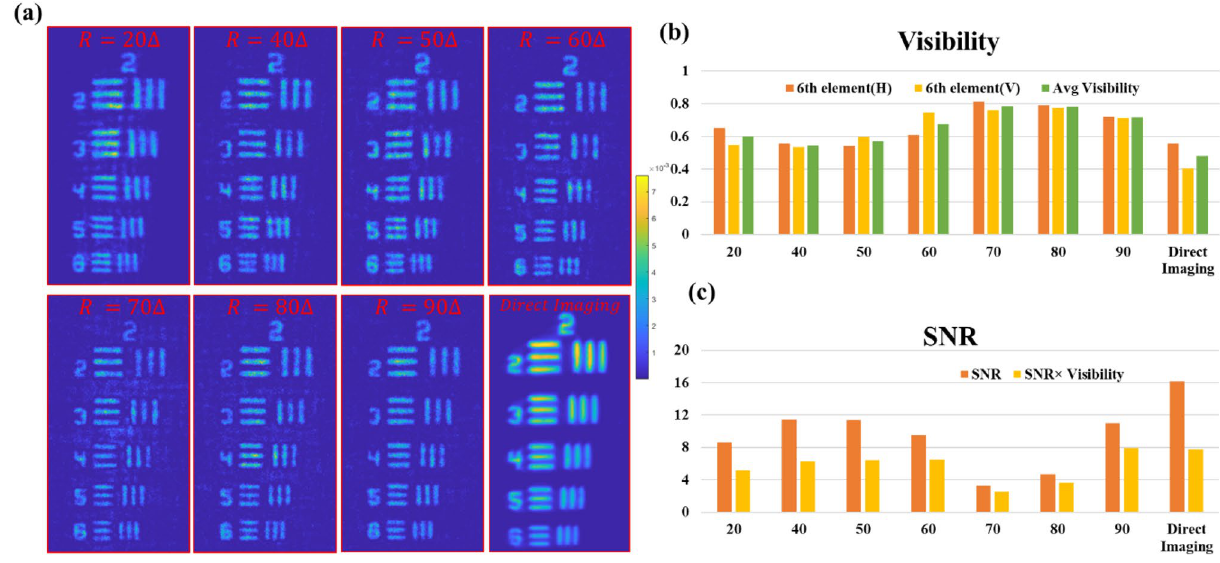
Figure 4. ( a ) Experimental comparison results of regular imaging and reconstruction results of the SCI- COACH system with a varying radius of the island, ( b ) Visibility chart of 6th element gratings, ( c ) SNR and SNR x Visibility chart.